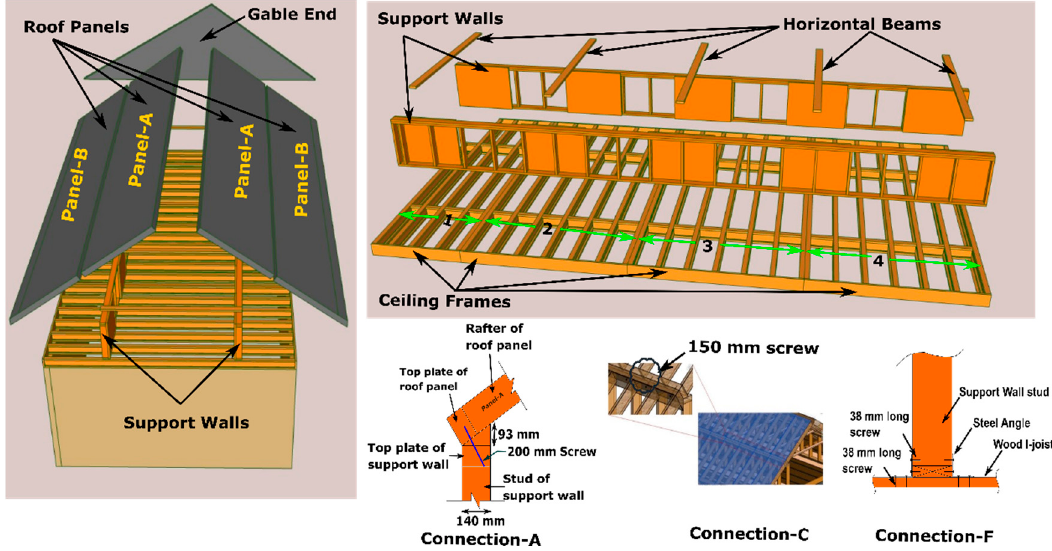
Figure 2. Light wood frame panelized roof concept.